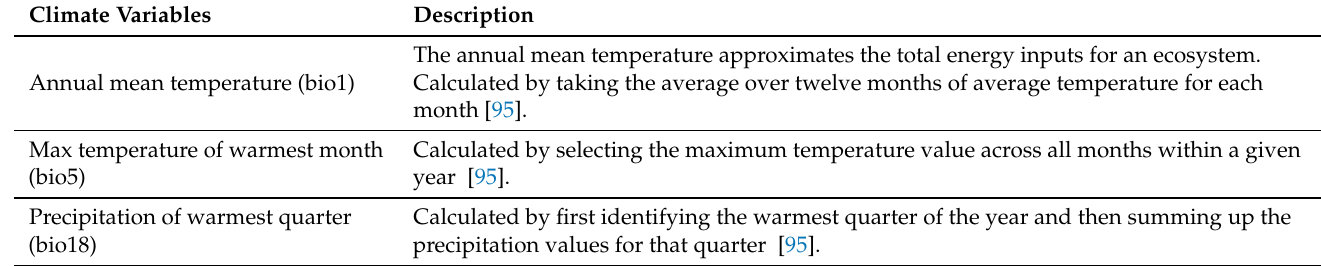
Table A2. Climate attributes obtained from Worldclim at a spatial resolution of 1km 2 and re-sampled at a resolution of 20 m for each